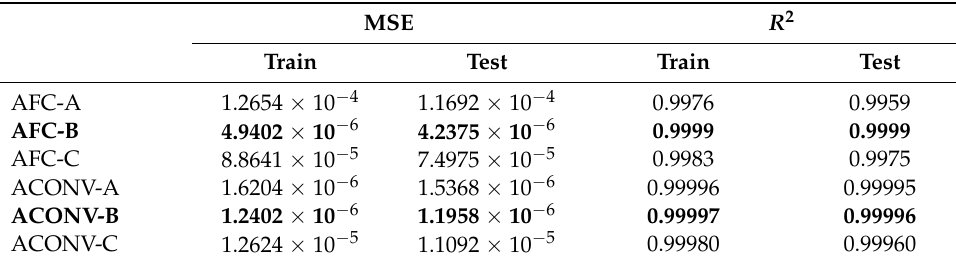
Table 7. Stacked autoencoder results for the dataset 3. The boldface indicates the best